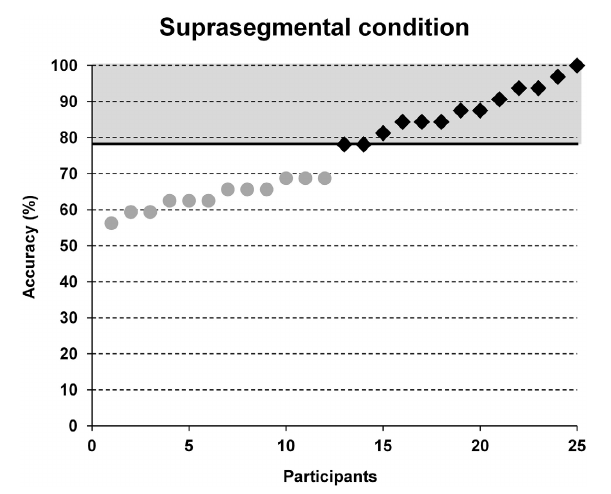
FIGURE 2 | Group classification based on a median split between accuracy results in the suprasegmental condition. Note that chance performance would yield 50% accuracy. Black squares = participants of the above average group, gray dots = participants of the below average